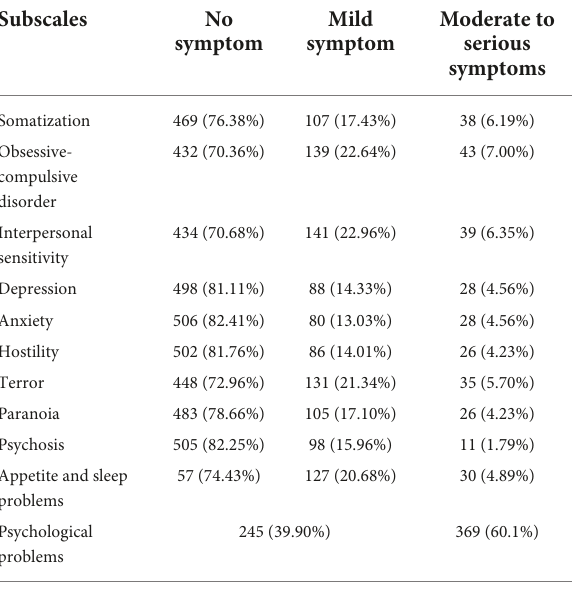
TABLE 2 Mental symptoms status diagnosed by